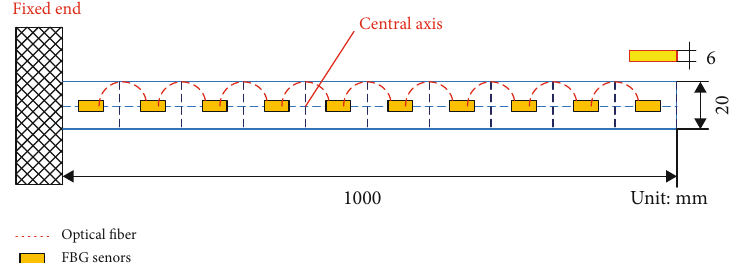
Figure 7: Beam element model and location of measurement